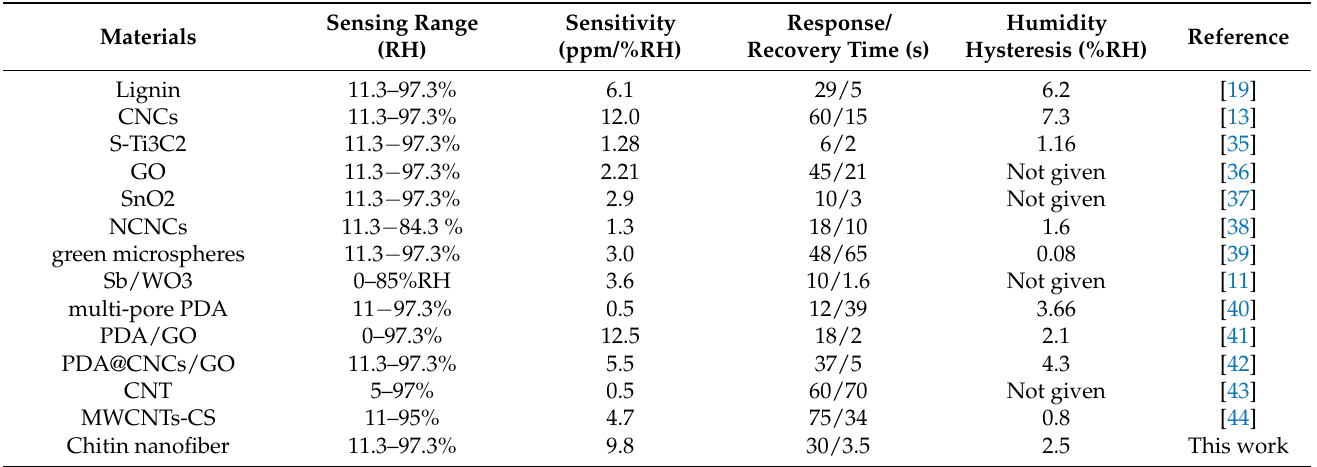
Table 3. Comparison of humidity sensing performance between ChNF-integrated n-m electrode QCM sensors and other QCM humidity sensors.